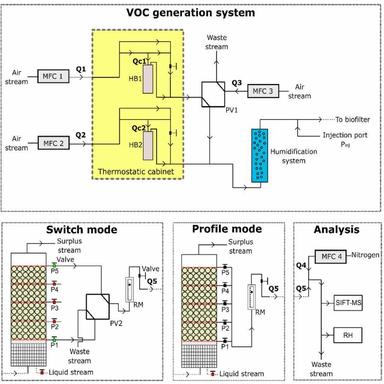
Experimental setup for the evaluation of a biofilter packed with expanded perlite.